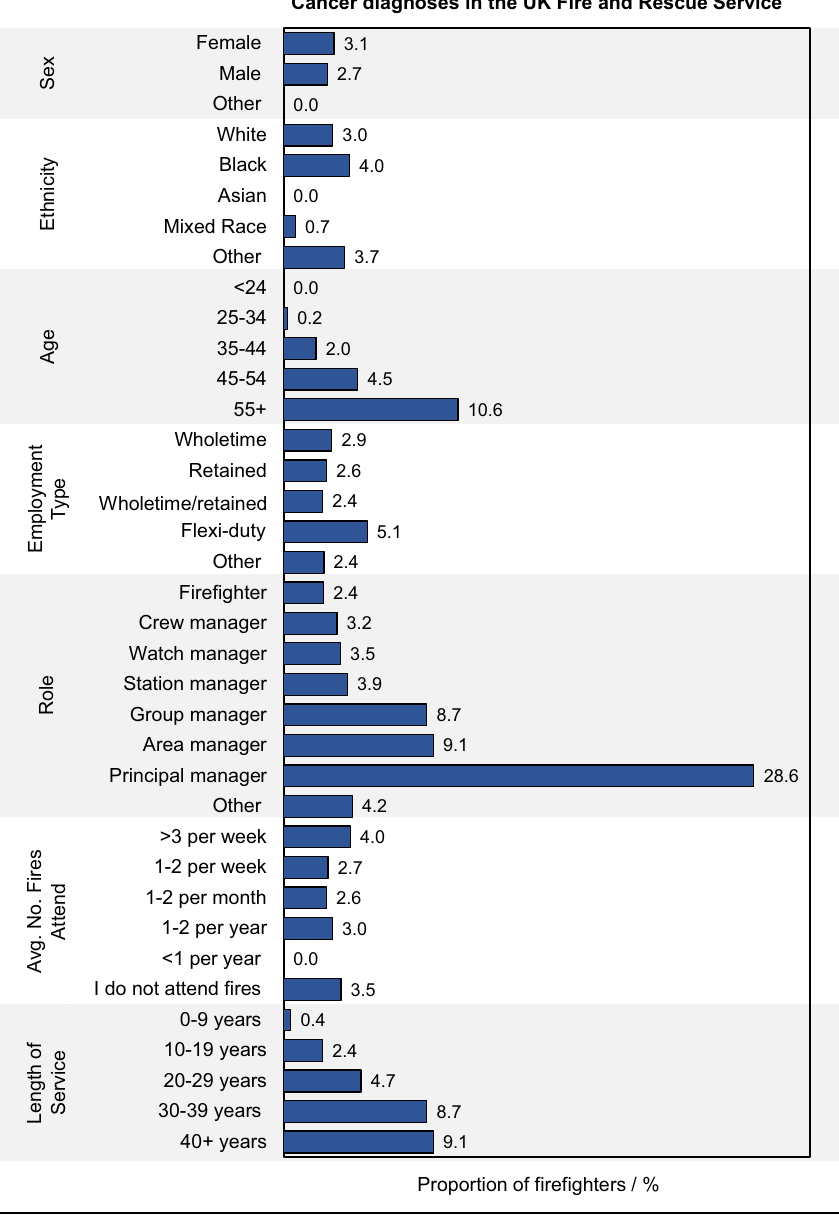
Figure 2. Demographics and Cancer Prevalence in the UK Fire and Rescue Service. The proportion of firefighters with a cancer diagnosis in each demographic category is presented (i.e. a percentage of the total number of female firefighters in the survey, male firefighters in the survey, etc.). Note that the relatively small sample size of certain demographic groups (e.g. female firefighters) mean the above results should be interpreted cautiously (see Wolffe et al., 2023 for demographic proportions). Also note that wholetime firefighters work full- time contracted hours/shift patterns. Retained firefighters do not have contracted hours, but are kept on a paid “retainer” contract, remaining on-call for emergencies. Wholetime/ retained firefighters represent wholetime firefighters who work a second retained contract outside of wholetime hours. Flexi-duty firefighters work full- time contracted hours in a more flexible shift